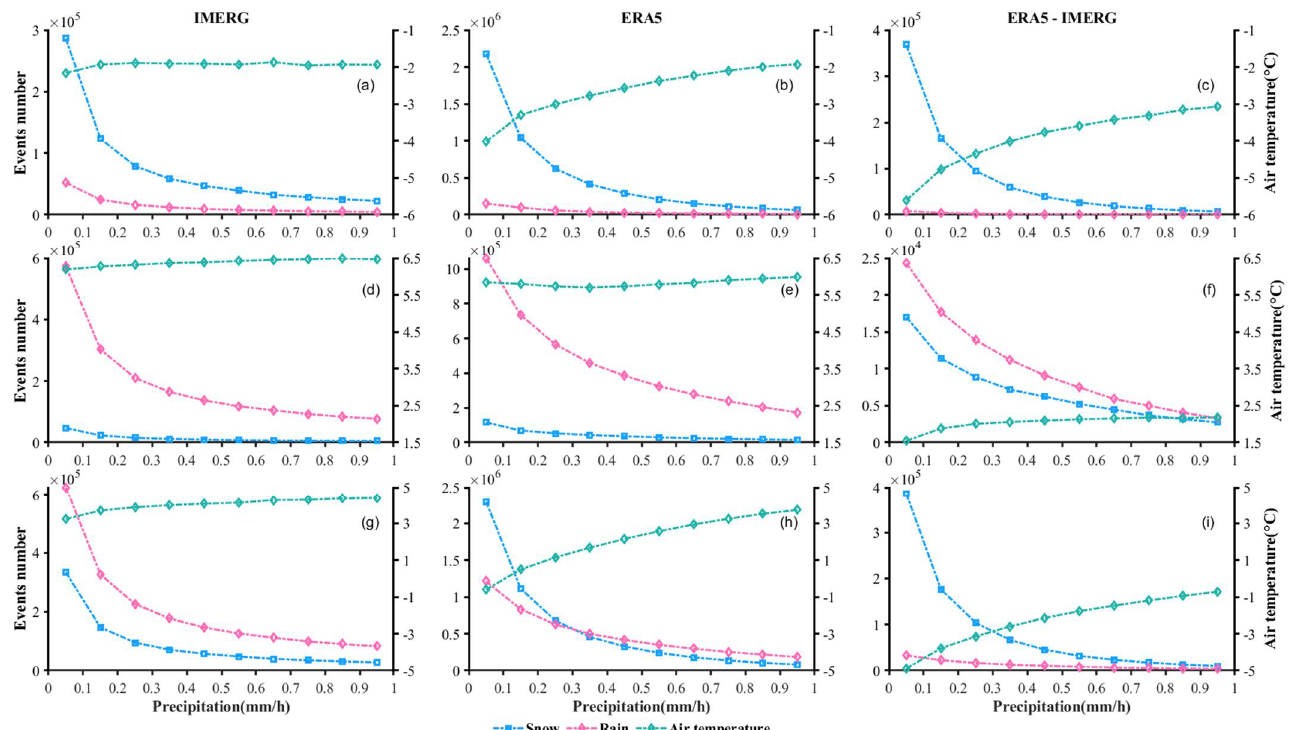
Figure 10. The snowfall events, rainfall events, and mean air temperature of IMERG and ERA5 products with different precipitation intensities on the global scale (including NH and SH land and oceans). Panels ( a – c ) are snowfall events only; ( d – f ) are rainfall events only; and ( g – i ) are snowfall and rainfall events.